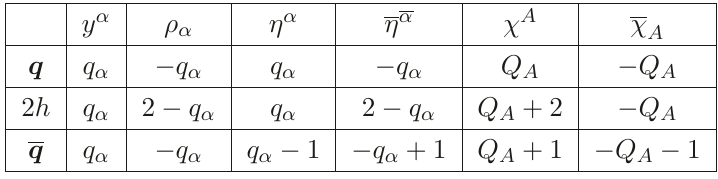
Table 1 . Weights and charges of the